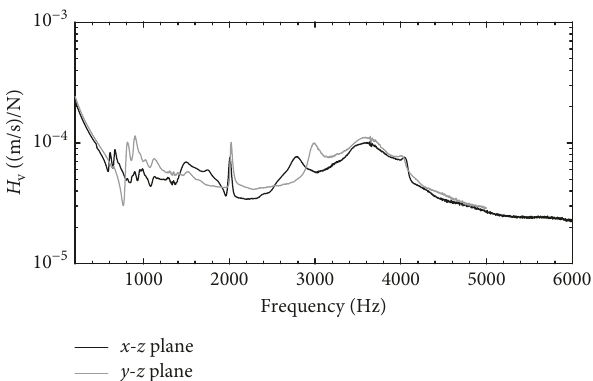
Figure 15: Comparison between the sum of the FRFs for the case of radial excitation and response measurement in the same direction, in two different radial planes ( x - z and y - z ).